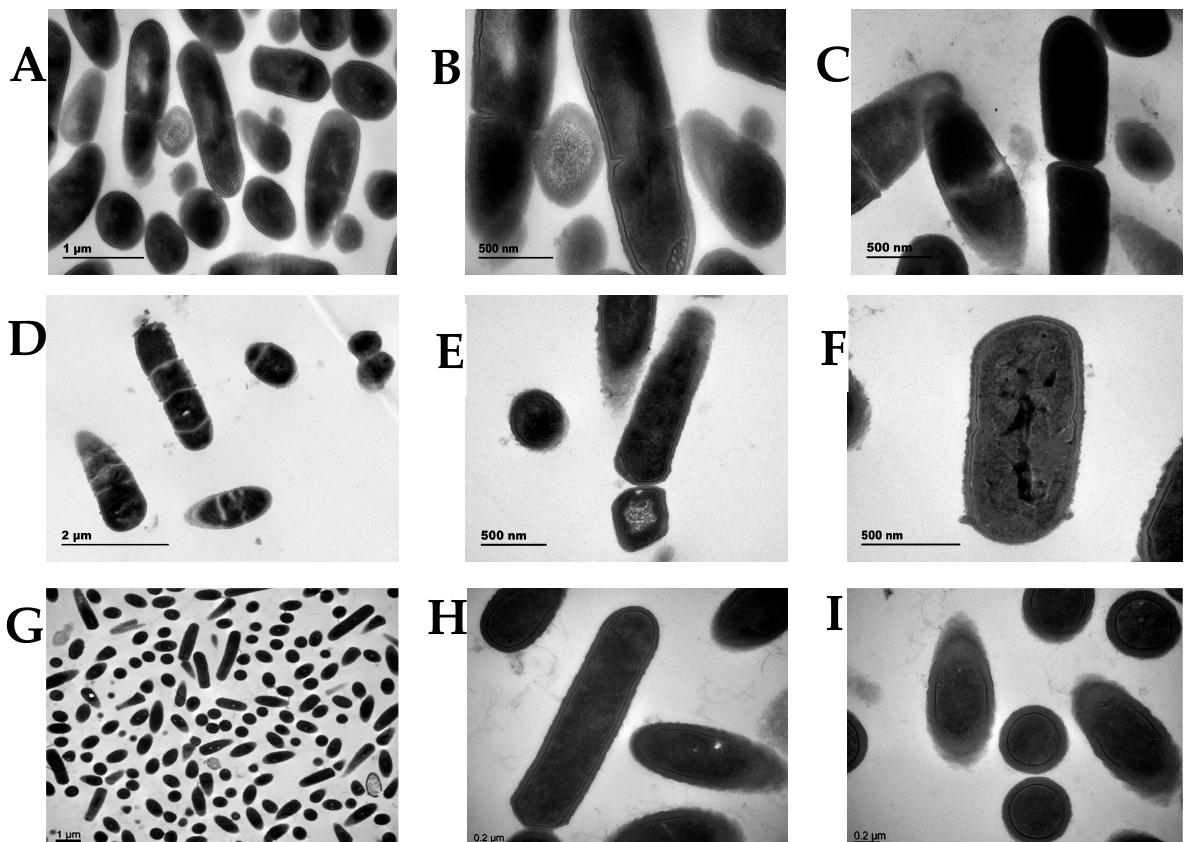
Figure 4. Colony morphology and microscopic morphology of the LA, ∆ galU, and p galU strains.